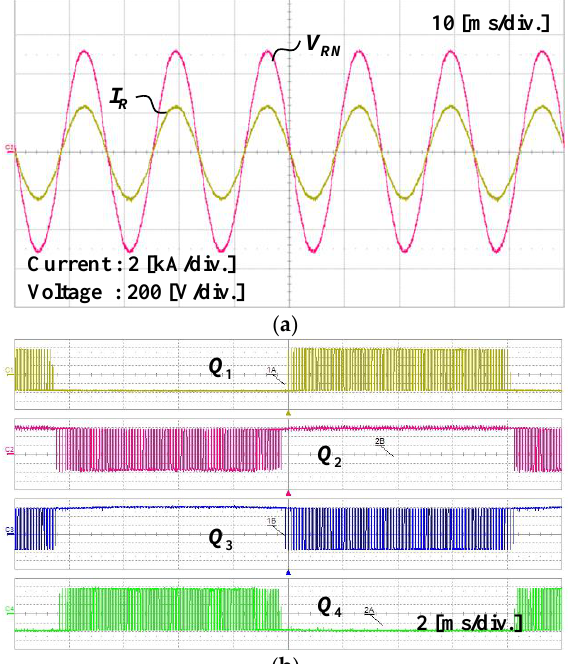
Figure 13. Experimental results in the case where the power factor is controlled at 1.0 using the conventional switching method: ( a ) waveforms of the output voltage and current; ( b ) waveforms of the gate signal.